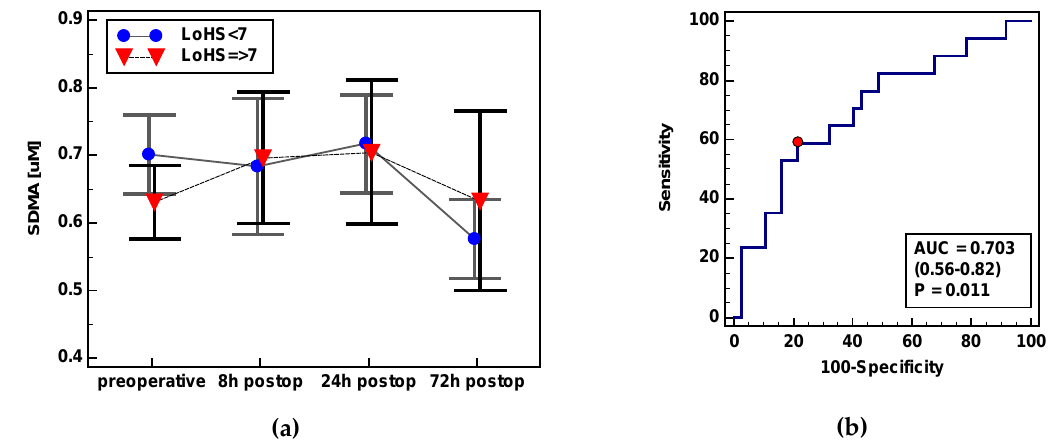
Figure 14. Association between SDMA concentration in the early postoperative period and length of hospitalization: ( a ) SDMA time-course in patients with length of hospital stay (LoHS) < and ≥ 7 days; ( b ) SDMA ∆ 72 / 0 as LoHS ≥ 7 marker. SDMA: Symmetric dimethylarginine; postop: Postoperative; AUC: Area under receiver operating characteristic (ROC) curve. Data at figure panel ( a ) presented as means with a 95% confidence interval and analyzed using repeated measures ANOVA. Data at figure panel ( b ) presented as AUC with a 95% confidence interval and p -value for difference from AUC = 0.5 characterizing a chance marker.